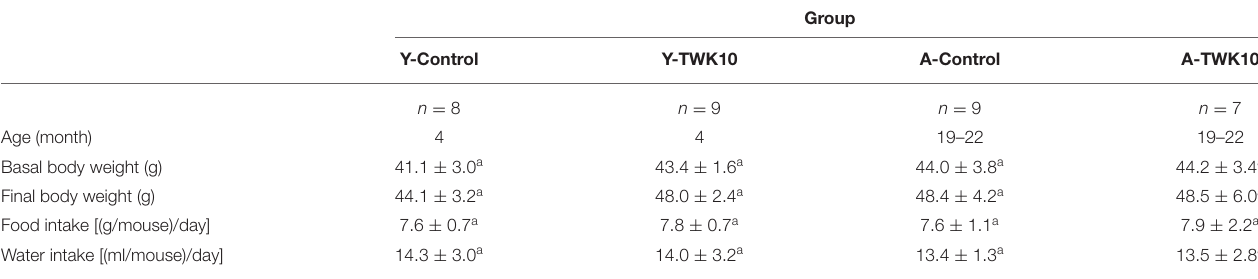
TABLE 1 | General characteristics of the